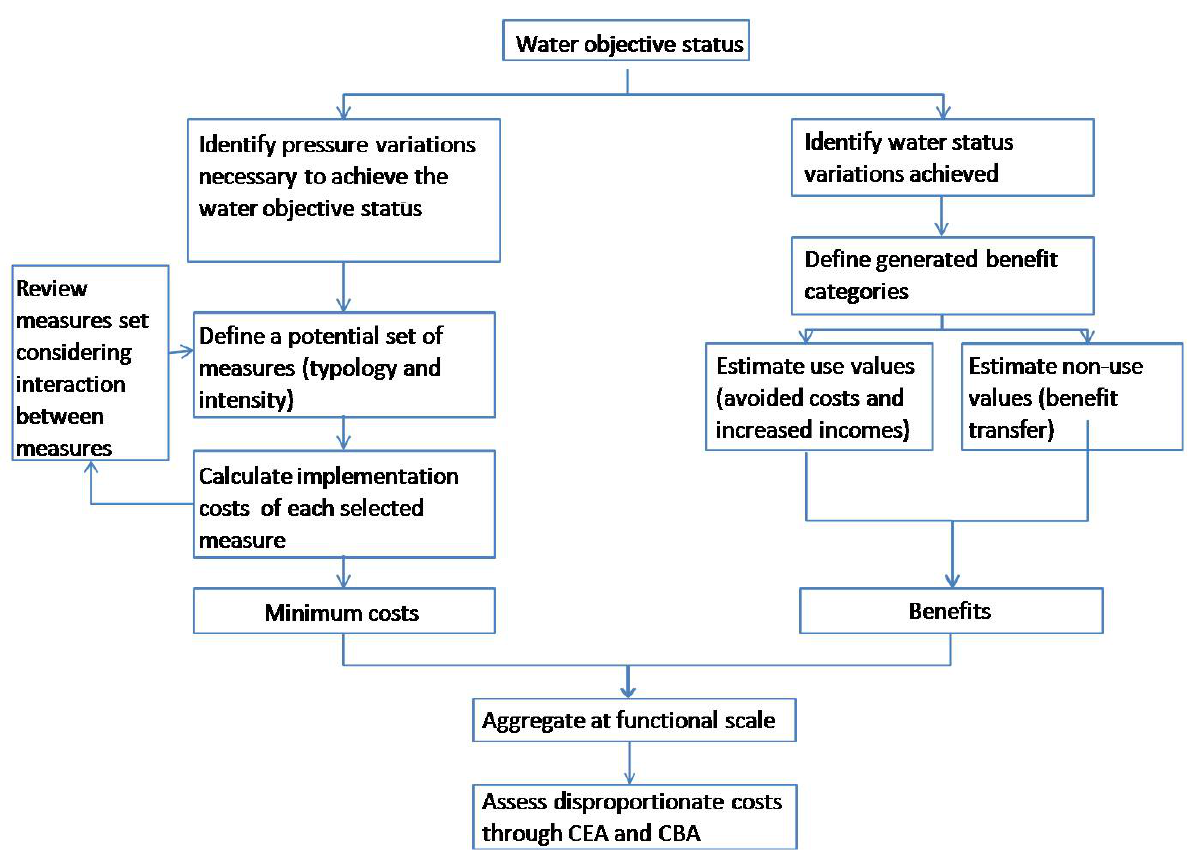
Figure 1. The application procedure. CEA, cost effectiveness analysis; CBA, cost benefit